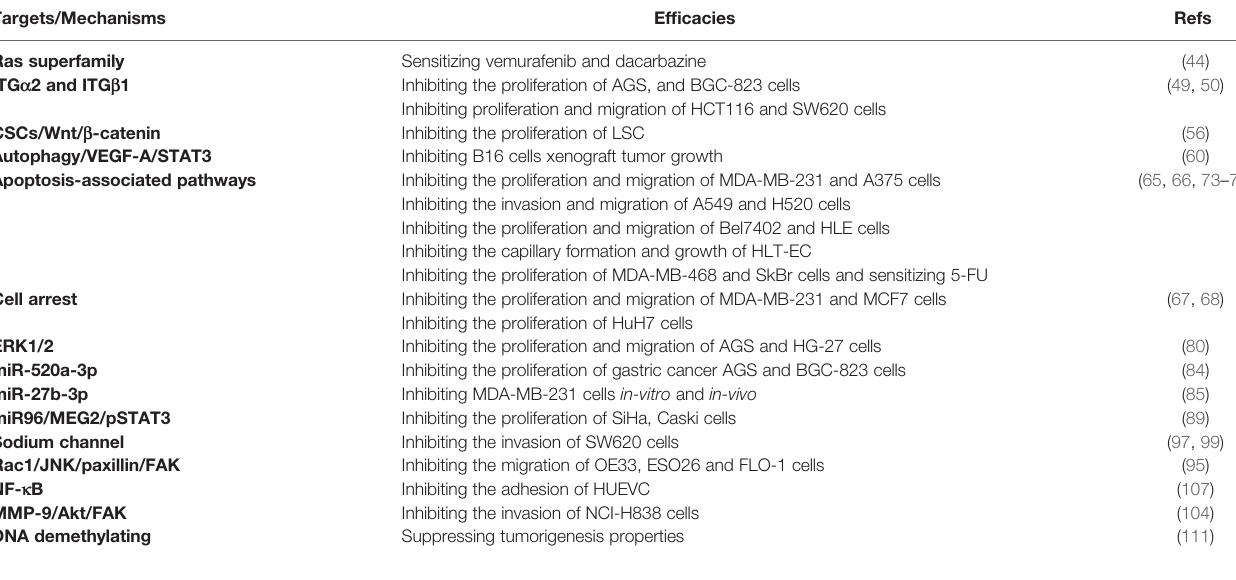
TABLE 1 | Summary of ropivacaine in cancer treatment.